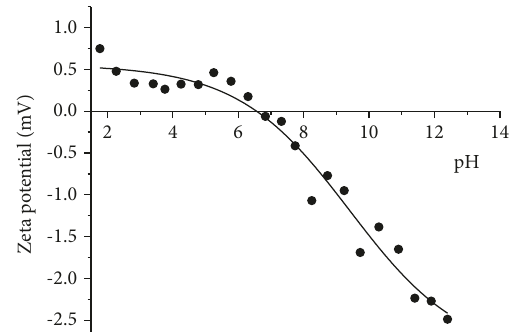
Figure 5: Zeta potential as a function of pH for the AC-ZnO material.